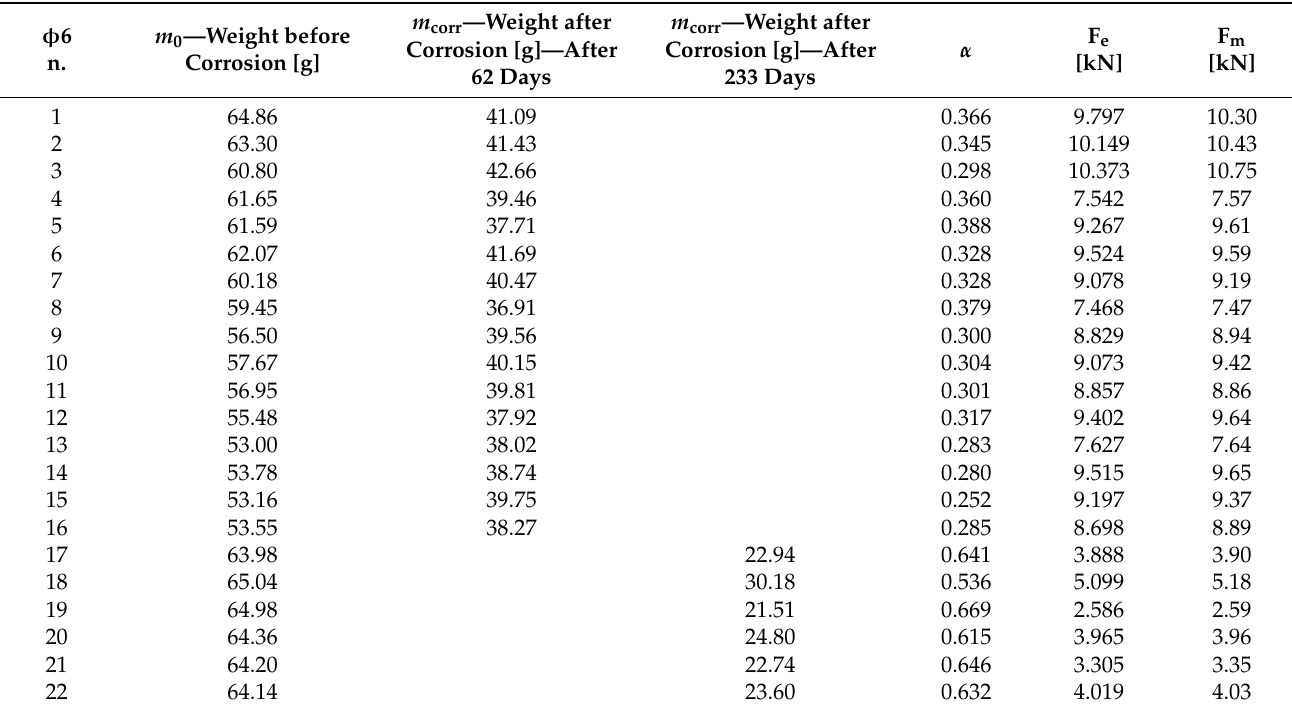
Table 2. The relative weight loss α , the force at yield strength F e and the force at tensile strength F m of cold-formed corroded reinforcement φ